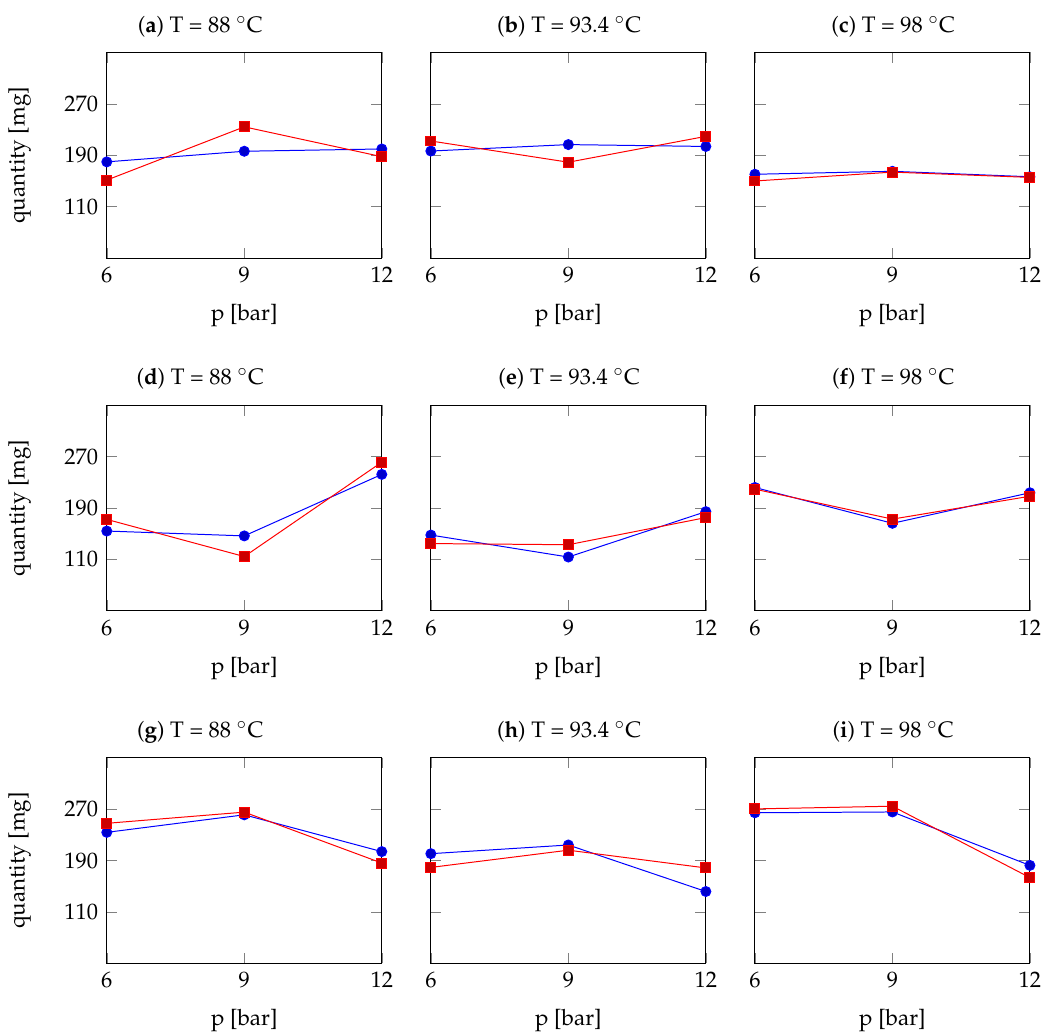
Figure 10. Comparison between the lipids extracted through numerical simulations (blue profile with circles) and laboratory measurements (red profile with squares), with different inlet water temperatures and pressures and different grain size of Arabica coffee powder. Figures ( a – c ) show the results of optimal granulometry, Figures ( d – f ) of coarse granulometry and Figures ( g – i ) of fine